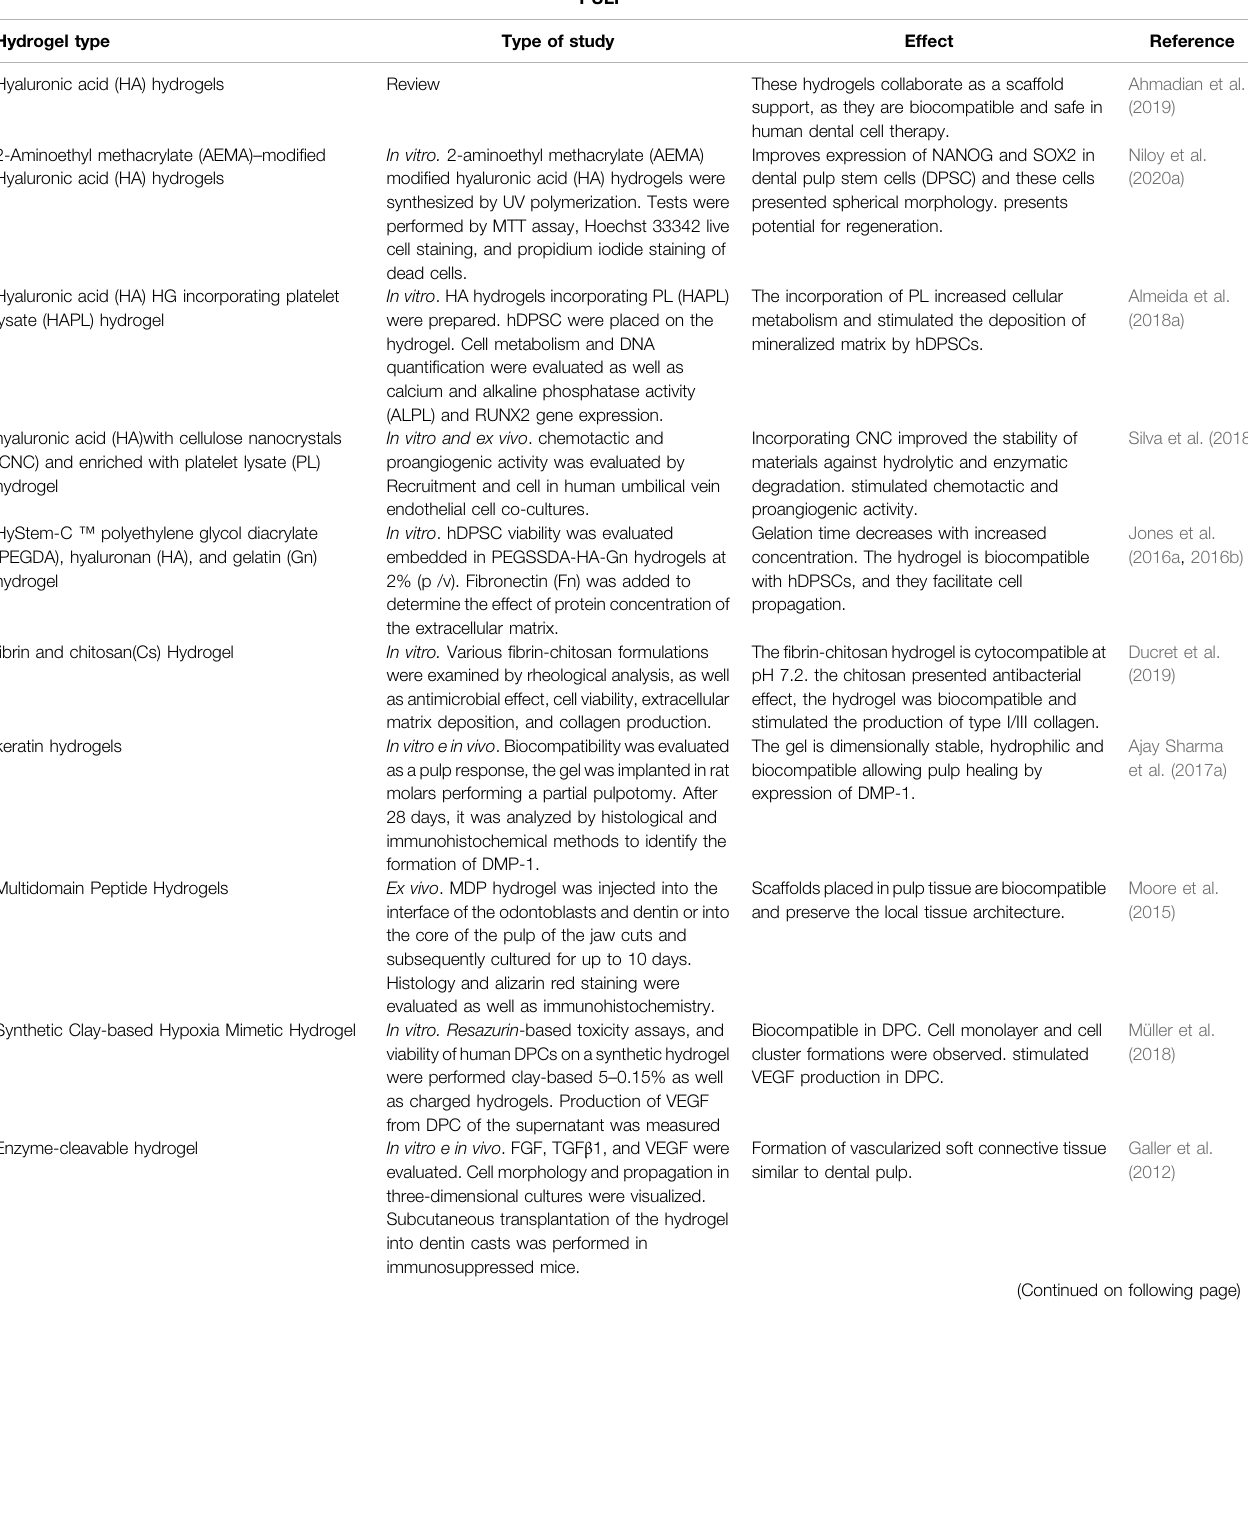
TABLE 1 | Hydrogel-based scaffolds for dental tissue